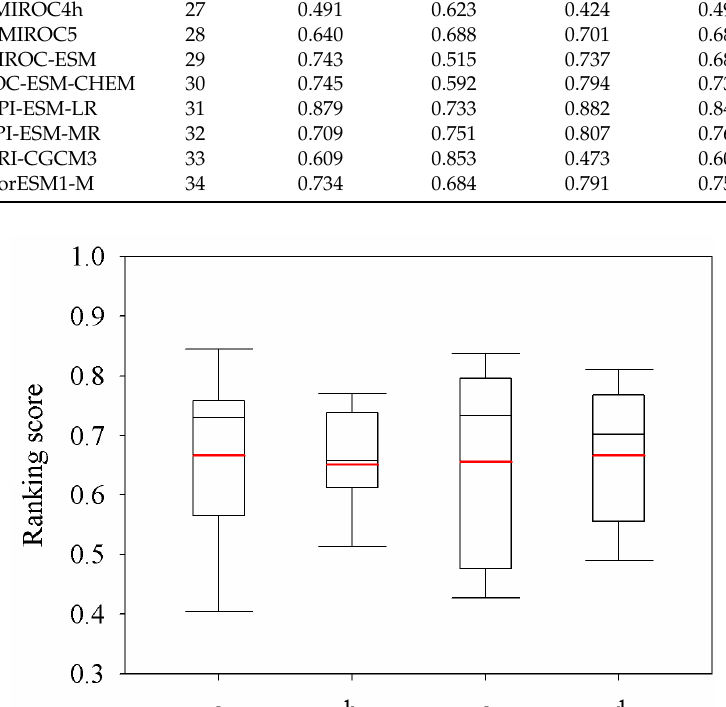
Figure 8. Box plots of ranking scores (ascending orders) for the performance of GCMs over the LMB: a, b, c, and d represent the wet season, dry season, annual time, and the overall results, respectively. The red and black lines in the box represent the mean value and the median value, respectively. The top and bottom horizontal lines represent the maximum value and the minimum value, respectively. The top and bottom horizontal lines on the borders of the box represent the upper quartile and the lower quartile, respectively.